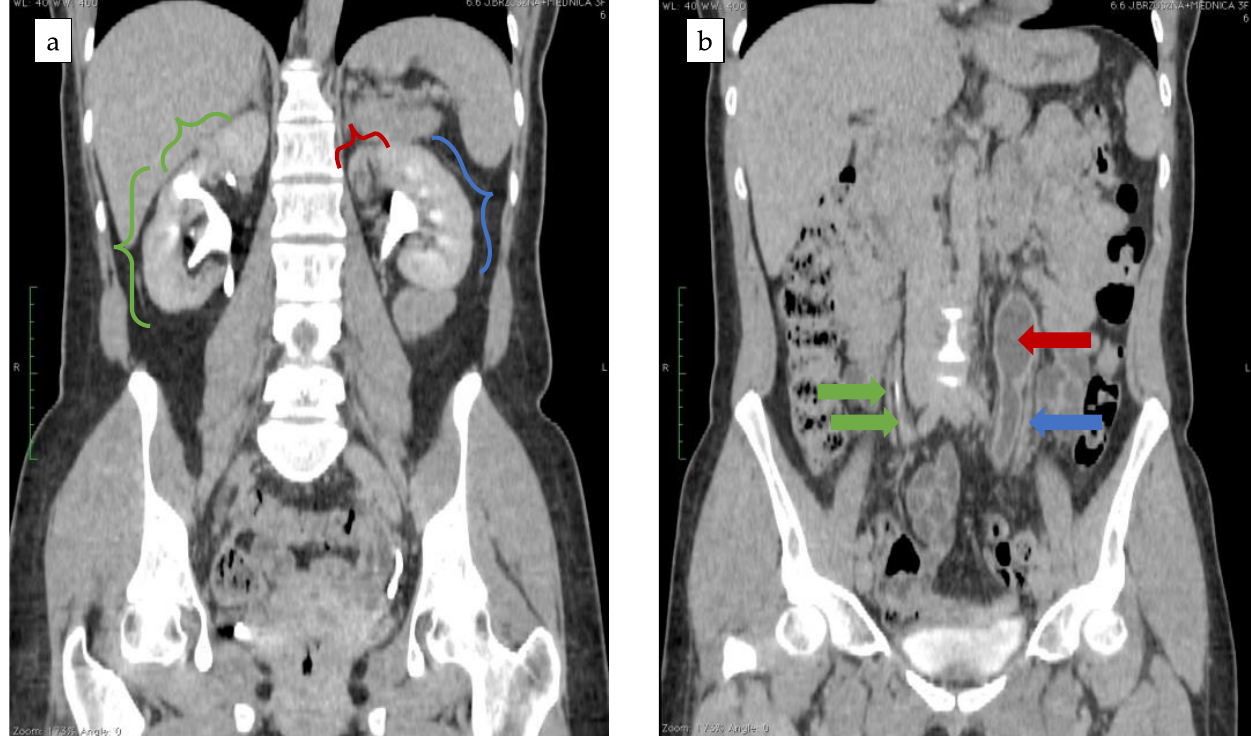
Figure 5. ( a ) Bilateral duplex kidney. Exertion of the contrast from both segments of right kidney (green brackets) and lower segment of the left kidney (blue bracket). No exertion of the contrast from upper moiety of the left kidney (red bracket). ( b ) Bilateral duplication of the ureter. Two contrasted ureters of the right kidney (green arrows). Contrasted ureter of the left kidney (blue arrow) and dilated, non-contrasted ureter of the upper moiety of the left kidney (red arrow). During diagnostic cystoscopy two orifices were found on the right side of the bladder trigon whereas only one orifice was found on the left side. The patient was diagnosed with ureteric enuresis and qualified for heminephrectomy of the upper moiety of the left